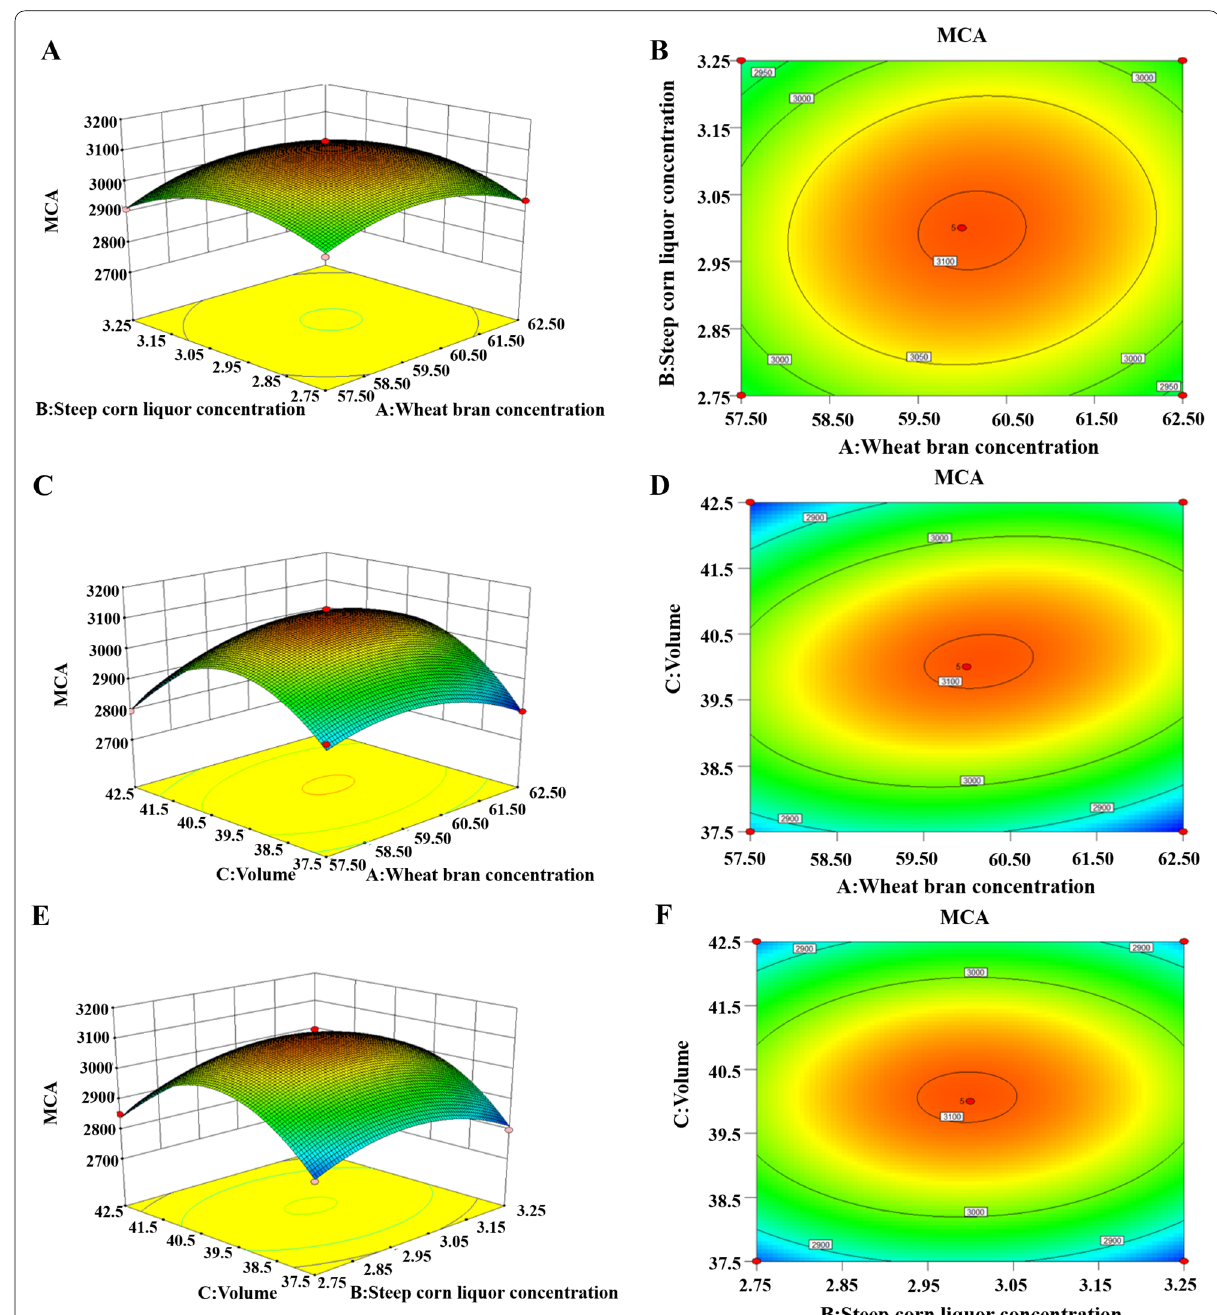
Fig. 8 Response surface and contour map of wheat bran concentration and corn steep liquor concentration interaction ( A , B ), wheat bran concentration and volume interaction ( C , D ) and corn steep liquor concentration and volume interaction ( E , F